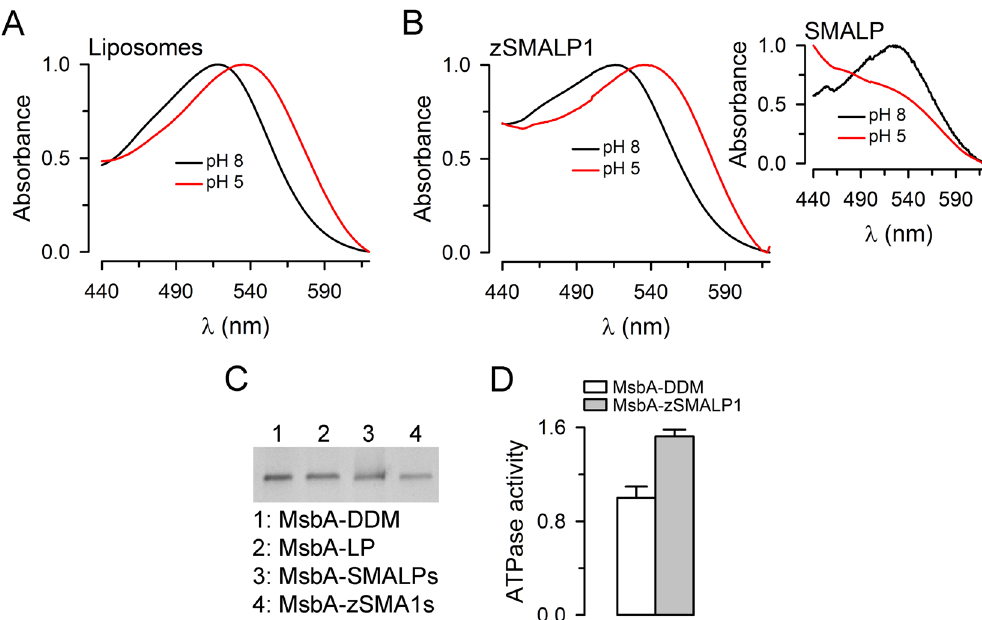
Figure 6. Activity assays of PR and MsbA in nanodiscs formed by zSMALP1. ( A ) Spectral shift of PR reconstituted in liposomes in response to lowering pH from 8 to 5. The data were normalized to the peak absorbance. ( B ) Spectral shift of PR reconstituted in zSMALP1s in response to lowering pH from 8 to 5. The data were normalized to the peak absorbance. The inset shows that the emission maximum is not clearly identifiable at pH 5 with the PR in SMALPs. At pH 5 the A 520 of PR in SMALPs decreased to 39% of the value at pH 8 due to precipitation (n = 2; see Fig. 1A, tube 6). In contrast, the A 520 of PR in zSMALP1s at pH 5 did not decrease (138 ± 13%; n = 3). ( C ) Solubilization/reconstitution of MsbA into SMALPs and zSMALP1s. Lane 1 (MsbA-DDM): purified MsbA in DDM; lane 2 (MsbA-LP): purified MsbA reconstituted into liposomes; lane 3 (MsbA-SMALP): MsbA reconstituted into liposomes and solubilized into SMALPs; lane 4 (MsbA-zSMALP1): MsbA reconstituted into liposomes and solubilized into zSMALP1s. The data correspond to bands stained with Instant Blue (Expedeon). ( D ) ATPase activity of MsbA. The ATPase activity of MsbA in zSMALP1s was slightly higher than that MsbA in the detergent DDM (P < 0.005; n = 6 for each condition). The data were normalized to the average activity in DDM (0.34 ± 0.03 ATP/s; n = 6). The activity of MsbA in SMALPs could not be measured because of the precipitation of MsbA-SMALPs in the presence of MgCl 2